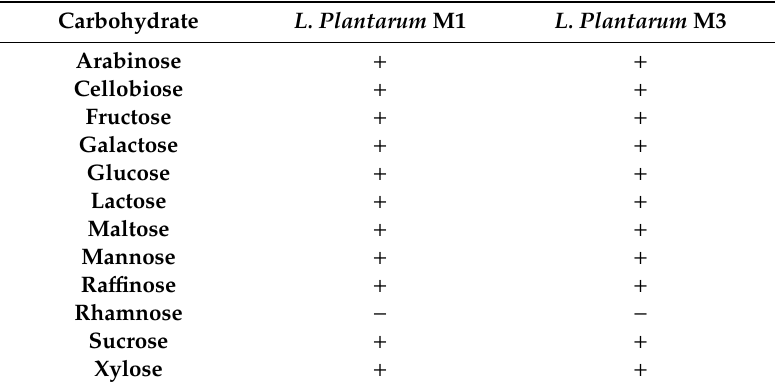
Table 2. Carbohydrate fermentation of L. plantarum strain.